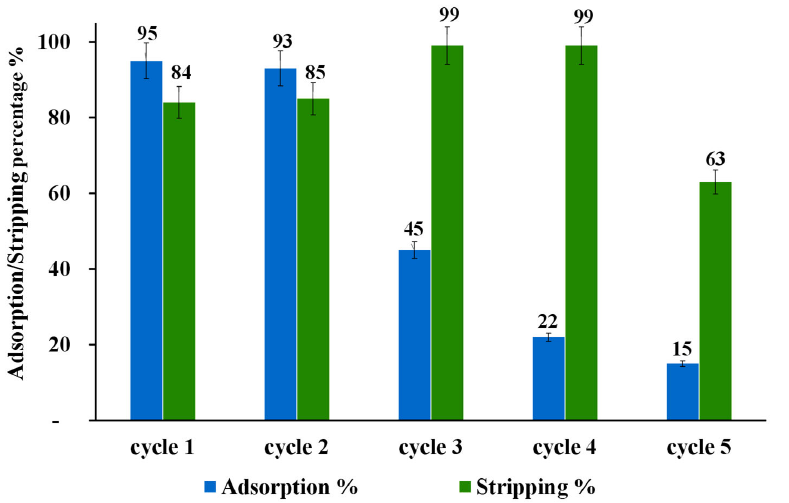
Figure 9. Effect of adding a 0.1 M NaOH washing step after each Au Adsorption/Stripping cycle using ZrO 2 ‐ L 6 .